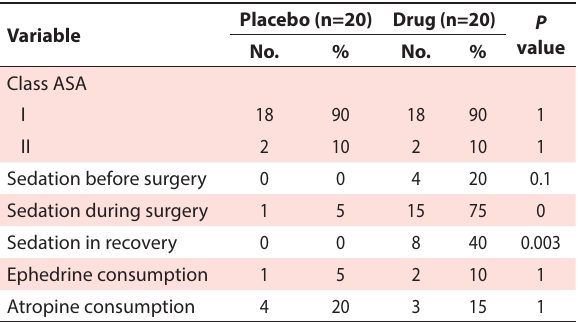
Table 3. Comparison of variables frequency (class ASA, sedation, atropine and ephedrine consumption) Placebo (n=20) Drug (n=20) P Variable valueNo.